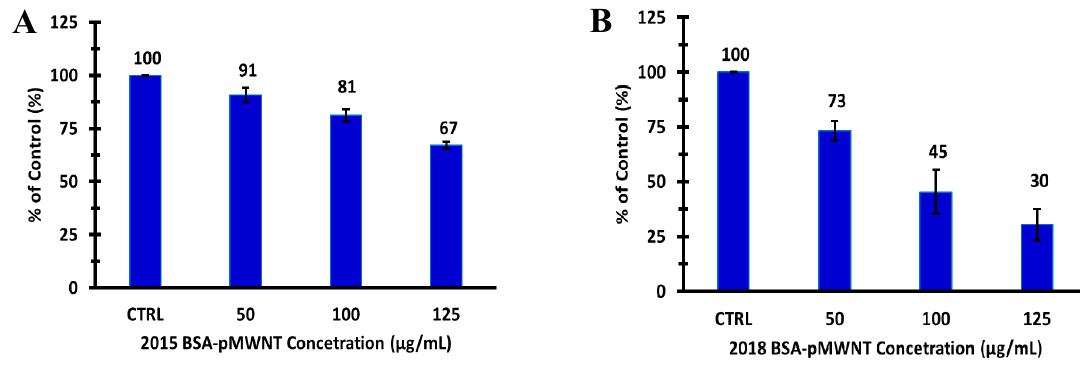
Figure 2. Cell proliferation of RAW 264.7 macrophages cultured with purified BSA-MWNT suspensions prepared with ( A ) 2015-pMWNTs and ( B ) 2018-pMWNTs. MWNTs suspended in